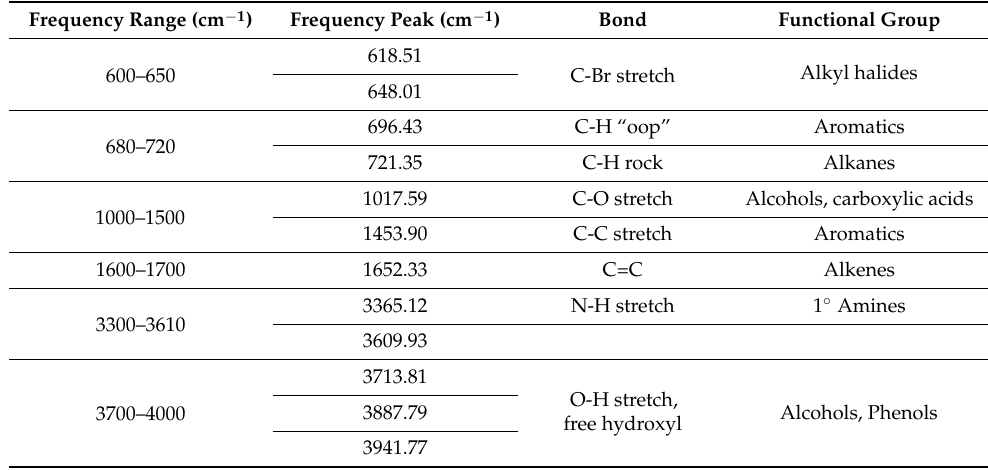
Table 2. FTIR peak values with functional group of C. orchioides A.L.